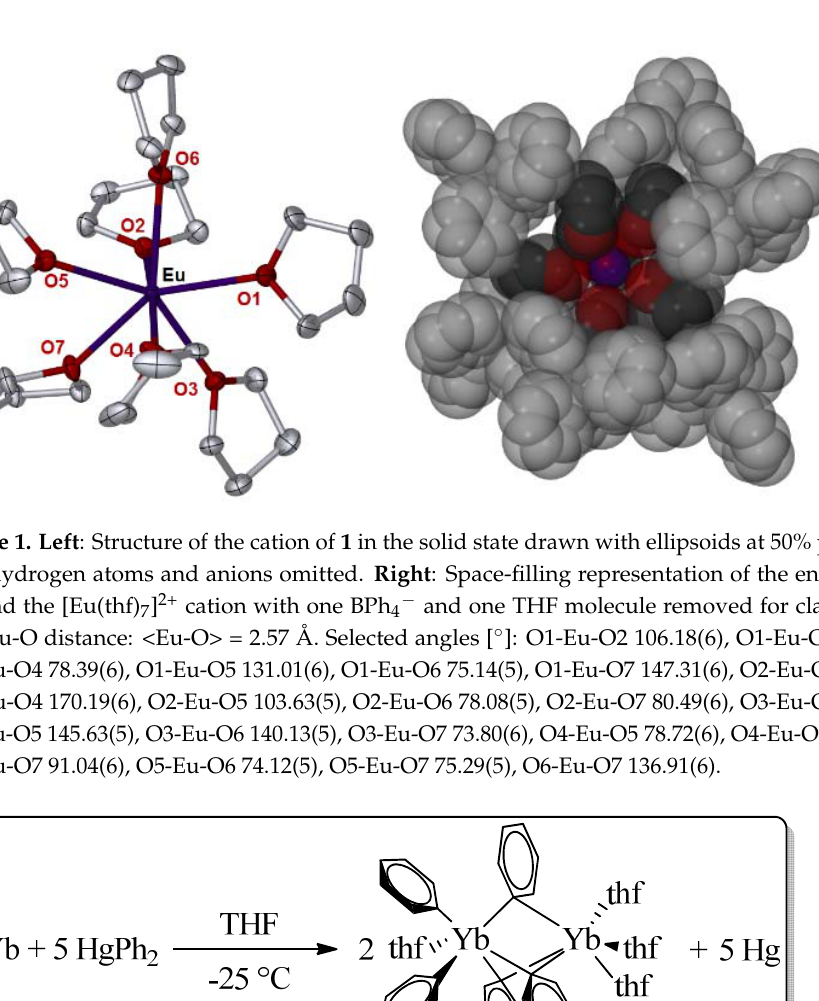
cube ‐ like shape around the cation (Figure 1 right). The Eu–O distance ranges from and hydrogen atoms and anions omitted. Right : Space ‐ filling representation of the environment 2.5214(17) to 2.6209(16) Å, and the average Eu ‐ O bond length (2.57 Å) in 1 is comparable around the [Eu(thf) 7 ] 2+ cation with one BPh 4  and one THF molecule removed for clarity. Average to that of [Sm(thf) 7 ][BPh 4 ] 2  thf [31], owing to the similar sizes of Sm 2+ and Eu 2+ [34]. Eu ‐ O distance: <Eu ‐ O> = 2.57 Å. Selected angles [°]: O1 ‐ Eu ‐ O2 106.18(6), O1 ‐ Eu ‐ O3 74.84(6), O1 ‐ Eu